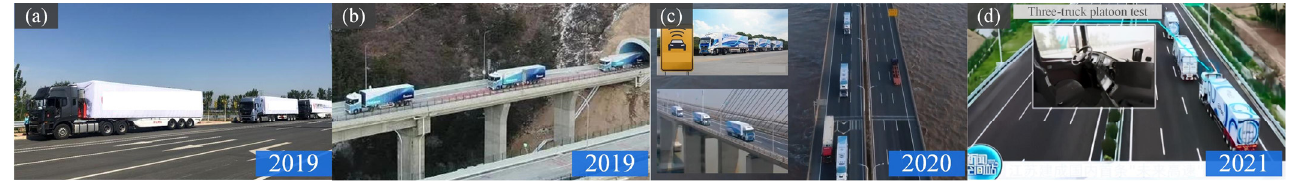
Figure 1. ATP tests conducted in China: ( a ) ATP public test for standard setting in Tianjin; ( b ) ATP tests on Beijing–Liquan highway; ( c ) ATP tests on Donghai Bridge in Shanghai; ( d ) ATP tests on a smart highway in Jiangsu.